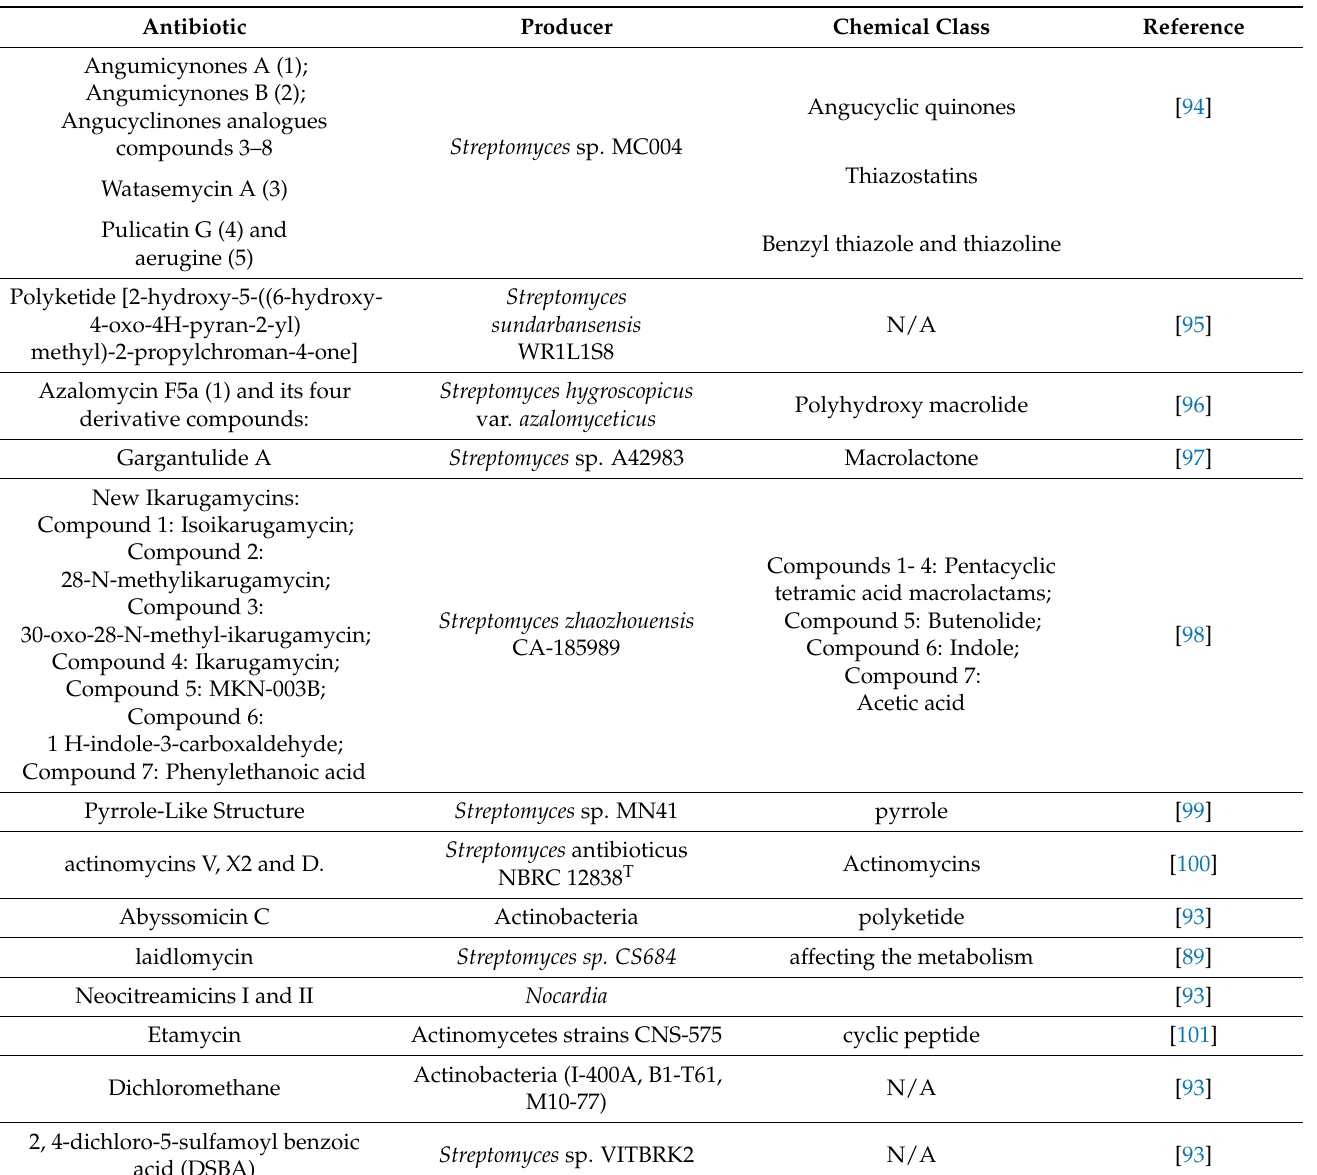
proteins and cell membrane biosynthesis inhibitors. The strains of Streptomyces sp. de- rived from different environments with potentials in production of anti-MRSA bioactive compounds from 2014 until 2020 is given in Table 4. Table 4. List of anti-MRSA activity of bioactive compounds, producers and their chemical classes isolated from Actinobacteria.